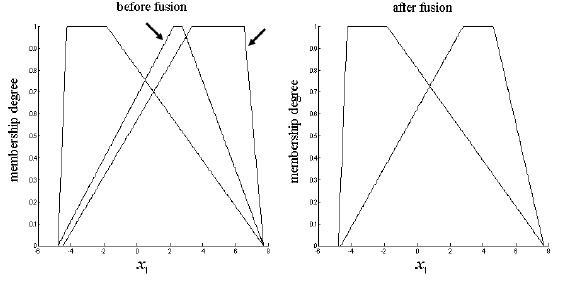
Fig. 10. Fusion of two similar FSs